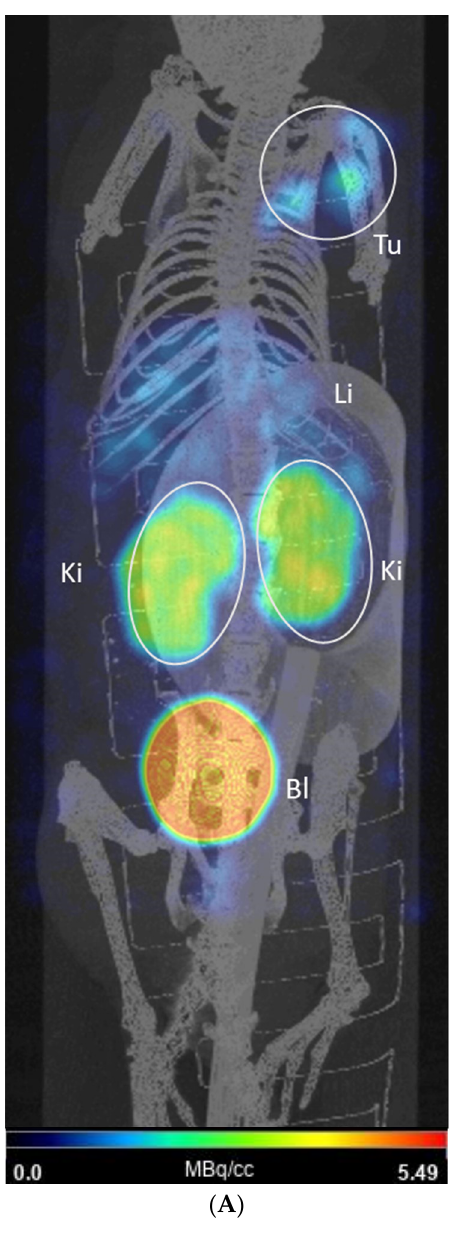
Figure 7. SPECT-CT images shown as maximum intensity projections for a mouse injected with 20 MBq of [ 153 Sm]Sm-DOTA-TATE. ( A ): Image obtained at 4 h post injection; ( B ): image obtained at 24 h post injection. The tumor (Tu) can be seen in the right shoulder. Other visible organs are kidneys (Ki), liver (Li) and bladder (Bl).